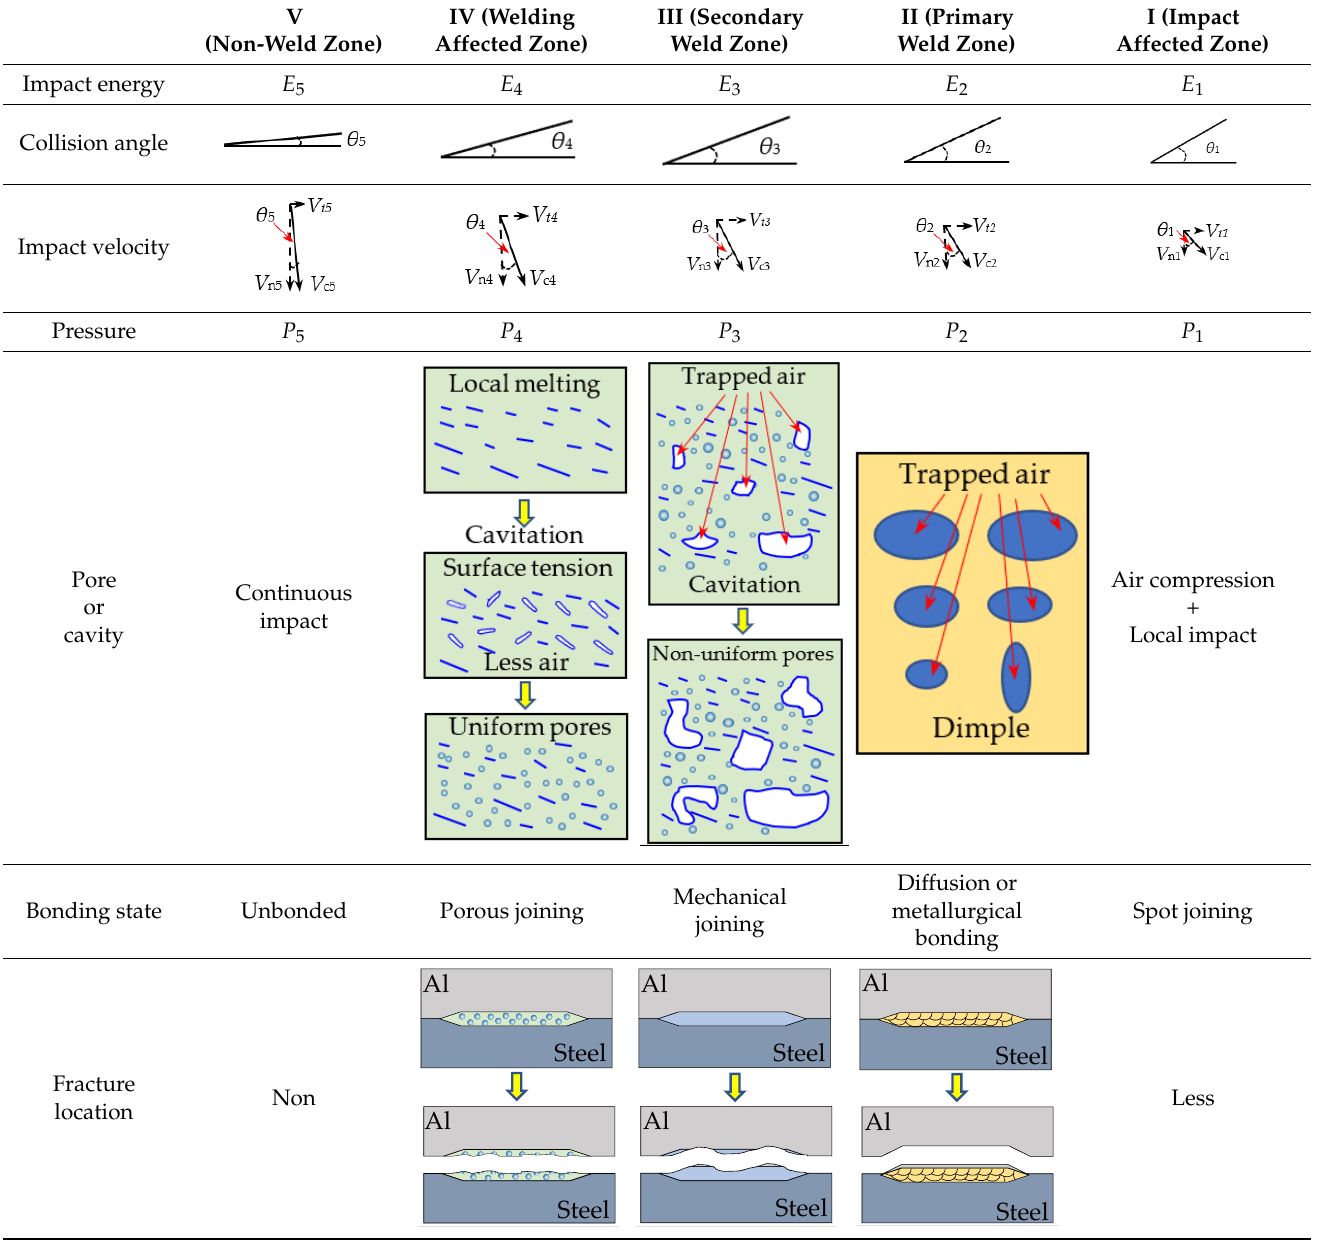
Figure 7. The evolution of hierarchical morphology of collision surface with changing impact energy, collision angle, and depressurization. Table 3 . Schematic diagrams showing the effect of impact-related factors on the interfacial characteristics. V